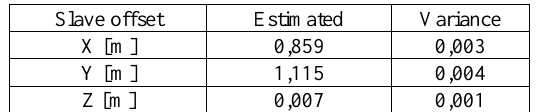
Table 3. The estimated offset of the SA3 slave camera from the SA2 master camera. The variance is used as a statistical indicator of the uncertainty of the estimation.